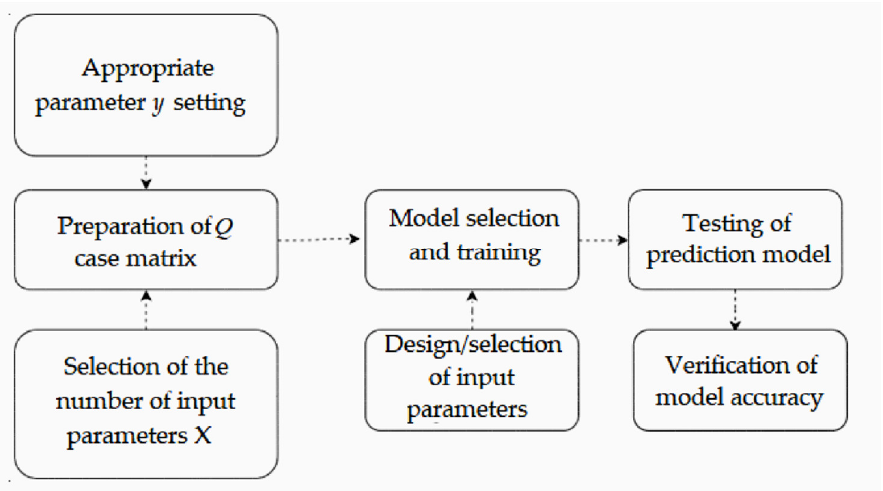
Figure 11. Design of training process of machine-learning models.